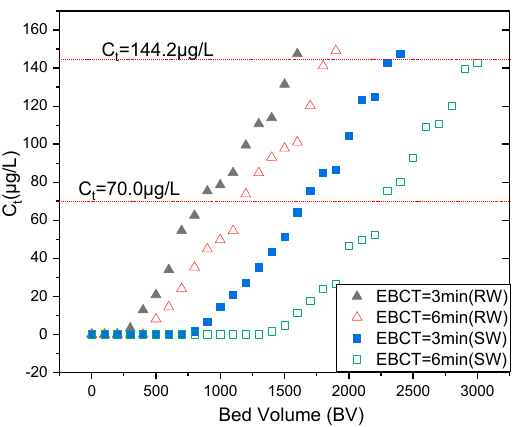
Figure 5. Mo(VI) breakthrough behavior of the column test from deionized water (temperature 25 ± 25 ± 1 ◦ C, influent pH 8.1 ± 0.1, initial SW and RW [Mo(VI)] 0.1603 mg / L, SW Mo(VI) and RW Mo(VI) 1 °C, influent pH 8.1 ± 0.1, initial SW and RW [Mo(VI)] 0.1603 mg/L, SW Mo(VI) and RW Mo(VI) empty-bed contact time (EBCT) = 3.0 and 6.0 empty-bed contact time (EBCT) = 3.0 and 6.0 min.